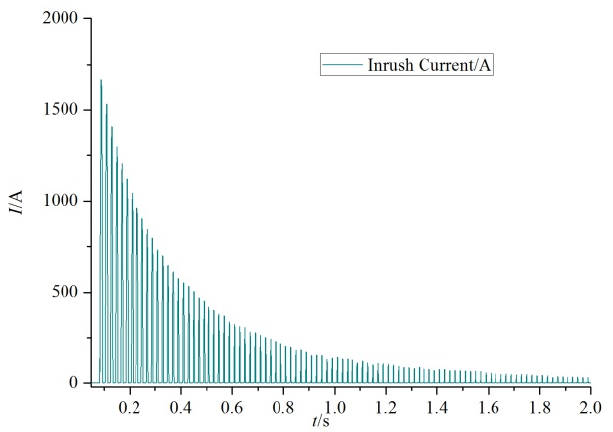
Figure 2. Flux waveforms of φ start with the residual flux φ r , and φ 0 = zero.